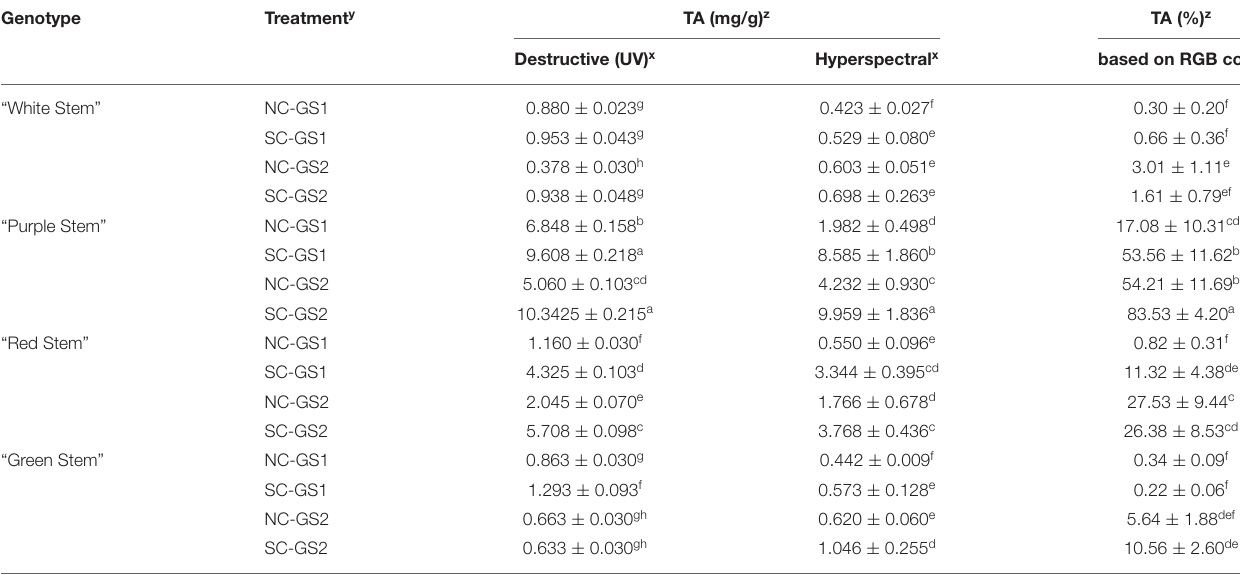
TABLE 1 | Variation of anthocyanin accumulation (mg/g) in leaf tissue of four bok choy cultivars grown under the different environmental conditions (NC and SC) with different growth stages (GS1 and GS2).